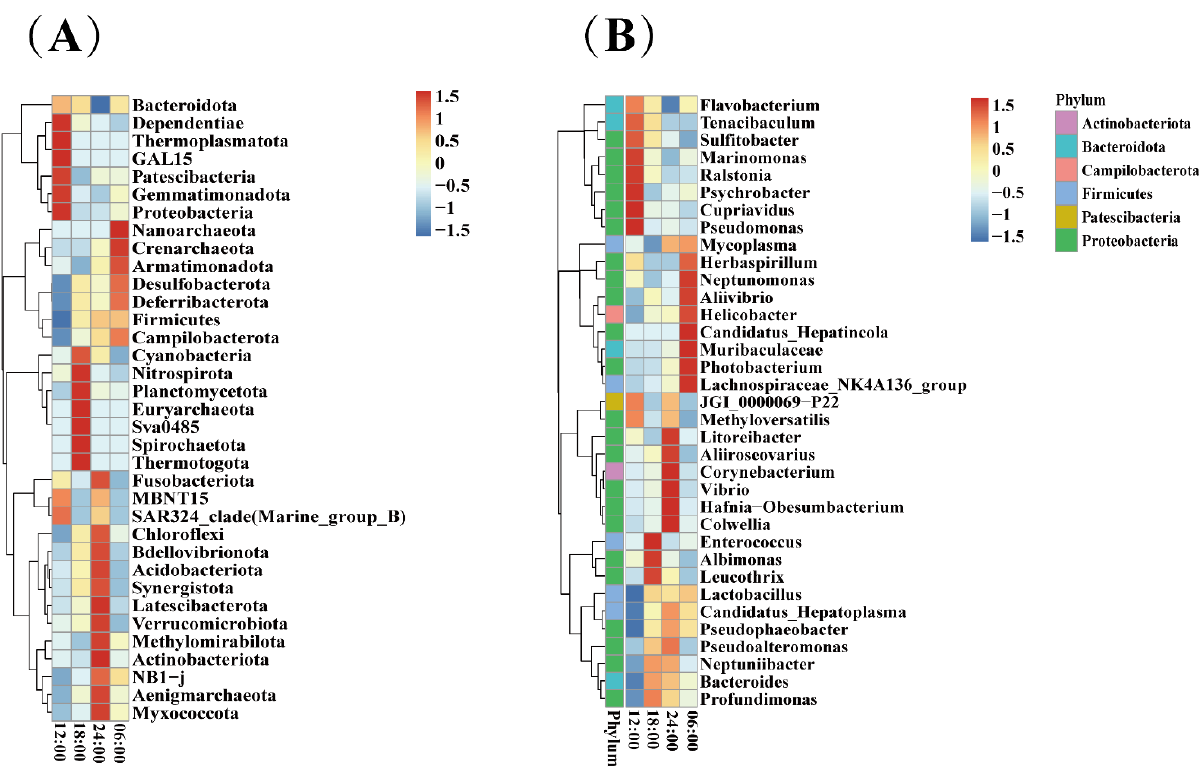
Figure 6. ( A ) Correlation analyses of the gut bacteria (phylum level). ( B ) Correlation analyses of the gut bacteria (genera level).